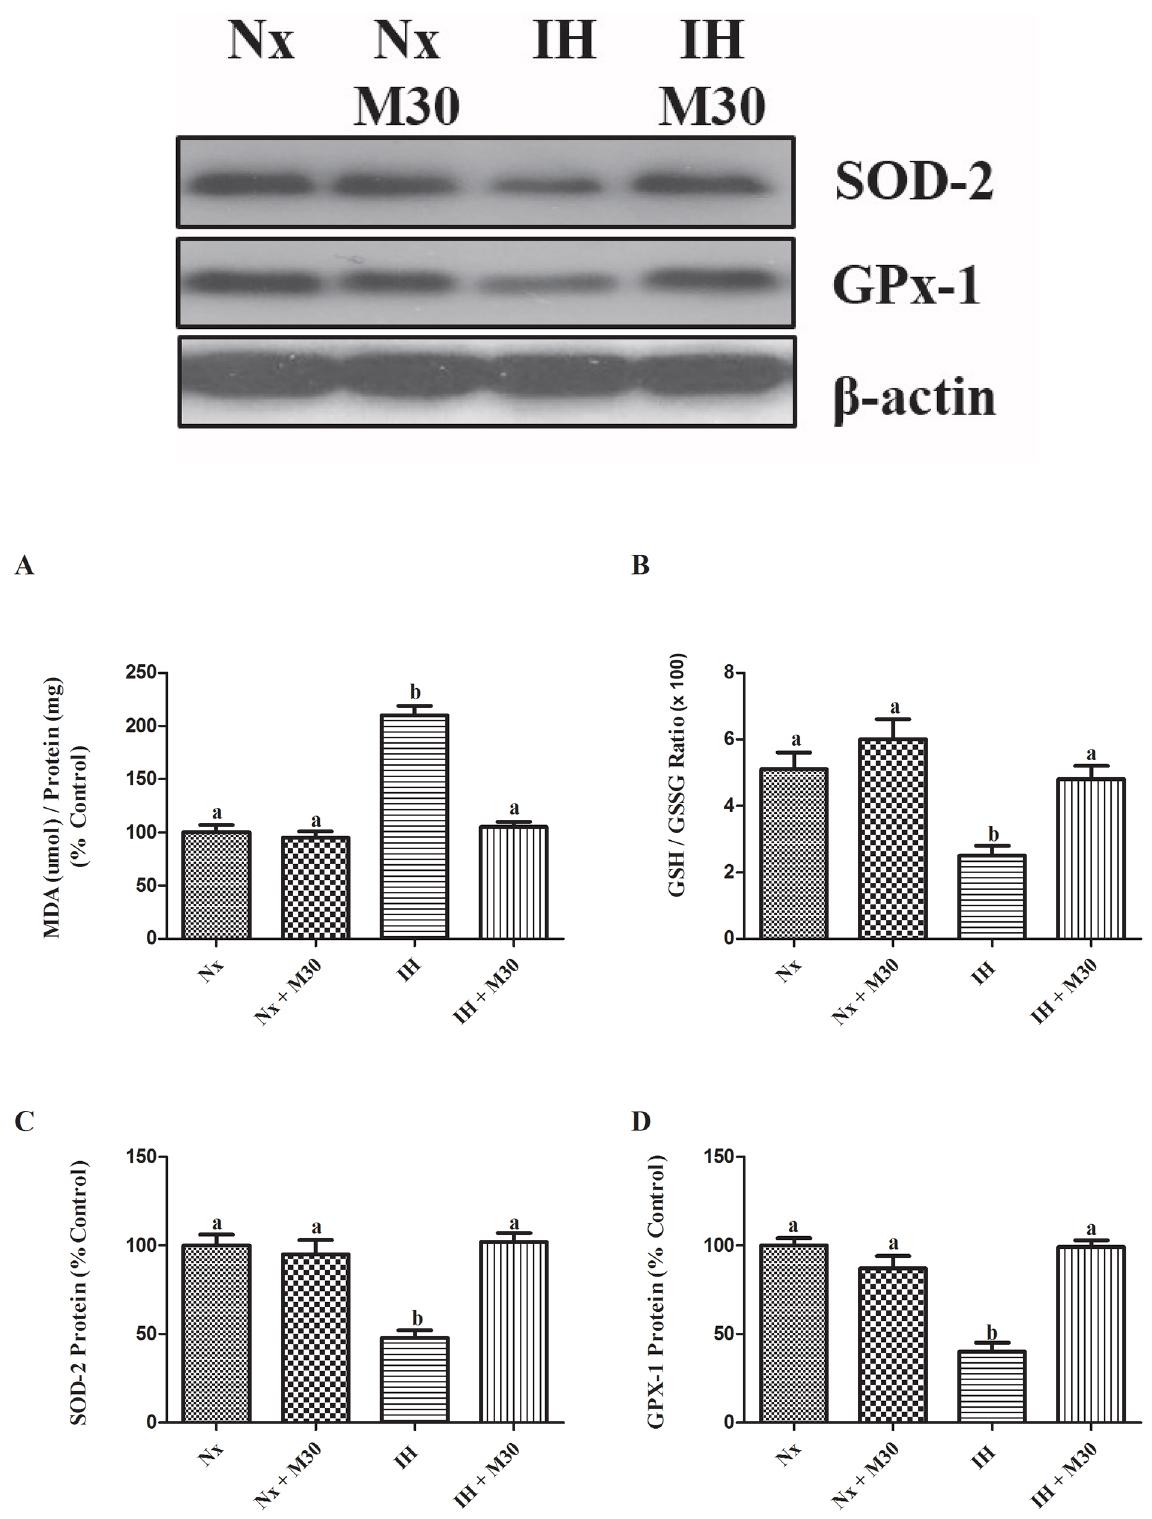
Fig 4. Administration of M30 attenuated oxidative stressinduced by hypoxia. Levelsof (A) MDA content, (B) GSH/GSSG ratio and the proteinexpression of (C) SOD-2 and (D) GPx-1 and in the hippocampus of the normoxic(Nx) or hypoxic(IH) groups; M30-treated hypoxic(IH+M30) or normoxic (Nx+M30) groups are summarized. β -actinwas an internalcontrol.Data are mean ± SEM